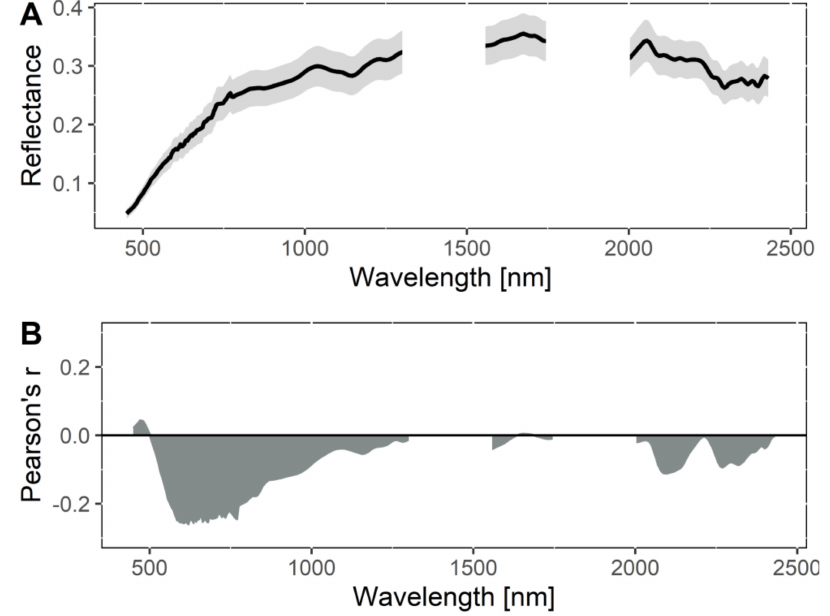
Figure 6. ( A ) Mean soil spectral signature (black line) and standard deviation (lower and upper boundaries) for the raw spectra of the 104 calibration samples extracted from the hyperspectral Airborne Prism Experiment (APEX) sensor (image from 2 September 2018) and ( B ) the Pearson’s correlation coe ffi cient of the soil organic carbon content with the raw hyperspectral